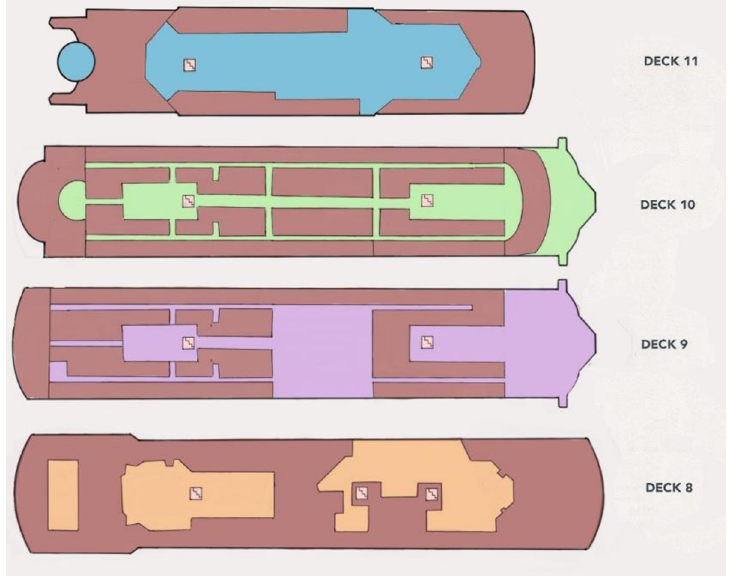
Fig 7. The evacuation route arrangement plan.